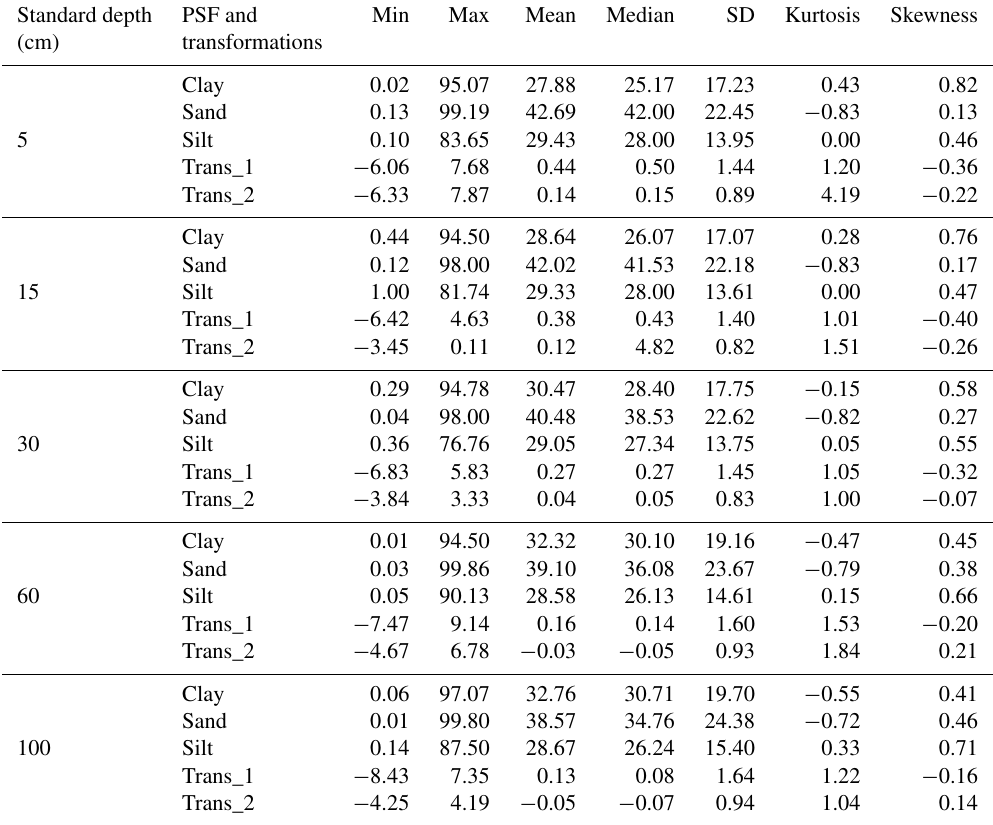
Table 2. Descriptive statistics of PSF and its transformations for each standard depth. Min: minimum; Max: maximum; SD: standard